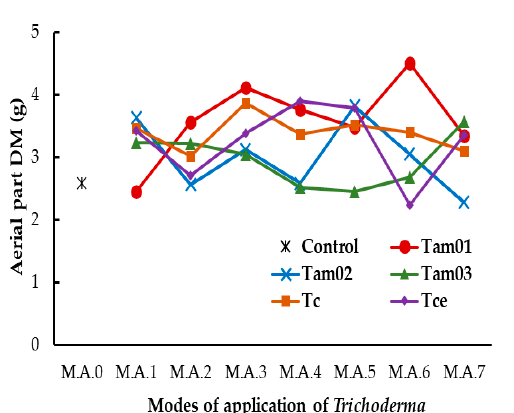
Figure 1. Average of height, collar diameter, number of leaves, root length, leaf foliar, root dry mass (DM), and aerial part dry mass of açaí seedlings submitted to different modes of application of Trichoderma isolates. M.A.0: without any application of Trichoderma (treatment control). M.A.1: